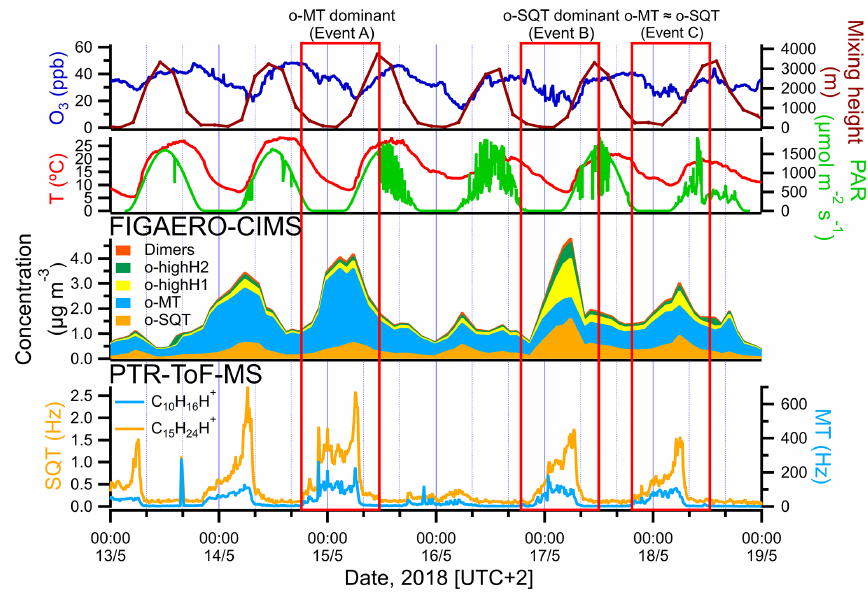
Figure 4. Amounts of sesquiterpenes (bottom left) and monoterpenes (bottom right) measured by PTR-ToF-MS, the total concentration of sesquiterpene and monoterpene oxidation products (o-SQT and o-MT), as well as o-highH1, o-highH2 and dimers, in the particle phase measured by FIGAERO-CIMS (middle), and meteorological parameters (temperature, PAR), mixing height (model-derived) and ozone mixing ratios (top) at the sampling site during the events. The m/z 137 and 205 were used as proxies for monoterpenes (C 10 H 16 H + ) and sesquiterpenes (C 15 H 24 H + ), respectively. Note the different axes for sesquiterpenes and